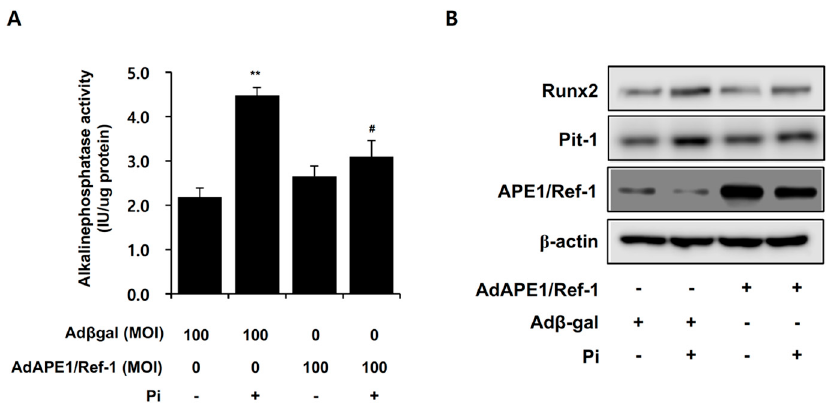
Figure 6. APE1/Ref-1 overexpression inhibits inorganic phosphate (Pi)-induced alkaline phosphatase (ALP) activity and Runx-2 and Pit-1 expression in vascular smooth muscle cells (VSMCs). ( A ) ALP activity was determined. At the end of incubation, cells were washed with phosphate-buffered saline and solubilized with 1% Triton X-100 in 0.9% NaCl, and ALP activity was normalized to protein concentration. Cells were treated with Pi (5 mM) for 6 days, and VSMCs were infected with an adenovirus encoding APE1/Ref-1 at a multiplicity of infection (MOI) of 100, with Ad β gal used at the same MOI as a control. Each bar represents the mean ± standard error of the mean ( n = 5). ** p < 0.01 vs. control; # p < 0.05 vs. Pi alone by one-way ANOVA; ( B ) APE1/Ref-1 inhibited Pi-induced Runx2 and Pit-1 expression in VSMCs. Changes in Runx2 and Pit-1 expression in VSMCs were evaluated by Western blot analysis. VSMCs were infected with an adenovirus encoding APE/Ref-1 at an MOI of 300, with Ad β gal used at the same MOI as a control. Similar results were observed in replicate experiments, and representative data is shown.